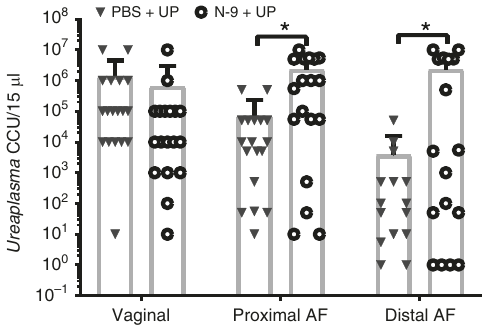
Fig. 5 Higher UP levels in the amniotic fl uid in the presence of cervical damage. In the afternoon of D16 of gestation, mice received either 10% N-9 in PBS or PBS control via intravaginal inoculation. After 16 h, in the morning of D17 of gestation, mice received either Ureaplasma parvum (UP) in ureaplasma-selective medium (USM) or USM control via intravaginal inoculation. After 48 h, in the morning of D19, vaginal fl ushes and amniotic fl uid (AF) from proximal and distal sacs were cultured in USM and UP titres were calculated using the microplate method. There was a signi fi cant increase in UP titres at the proximal and distal sites in the amniotic fl uid of mice pre-treated with N-9 ( n = 18) compared to pre-treatment with PBS ( n = 18). No bacterial growth was detected in uninfected mice. Each dot in the dot plots represents the average of left and right horn for each mouse at either site. Error bars indicate SD. Statistical signi fi cance was assessed using unpaired t test with Welch ’ s correction on the log-transformed values of Ureaplasma parvum titres for PBS + UP vs. N-9 + UP at all three sites (* P < 0.05; P = 0.0356 for amniotic fl uid proximal, P = 0.0466 for amniotic fl uid distal). Source data are provided as a Source Data File.